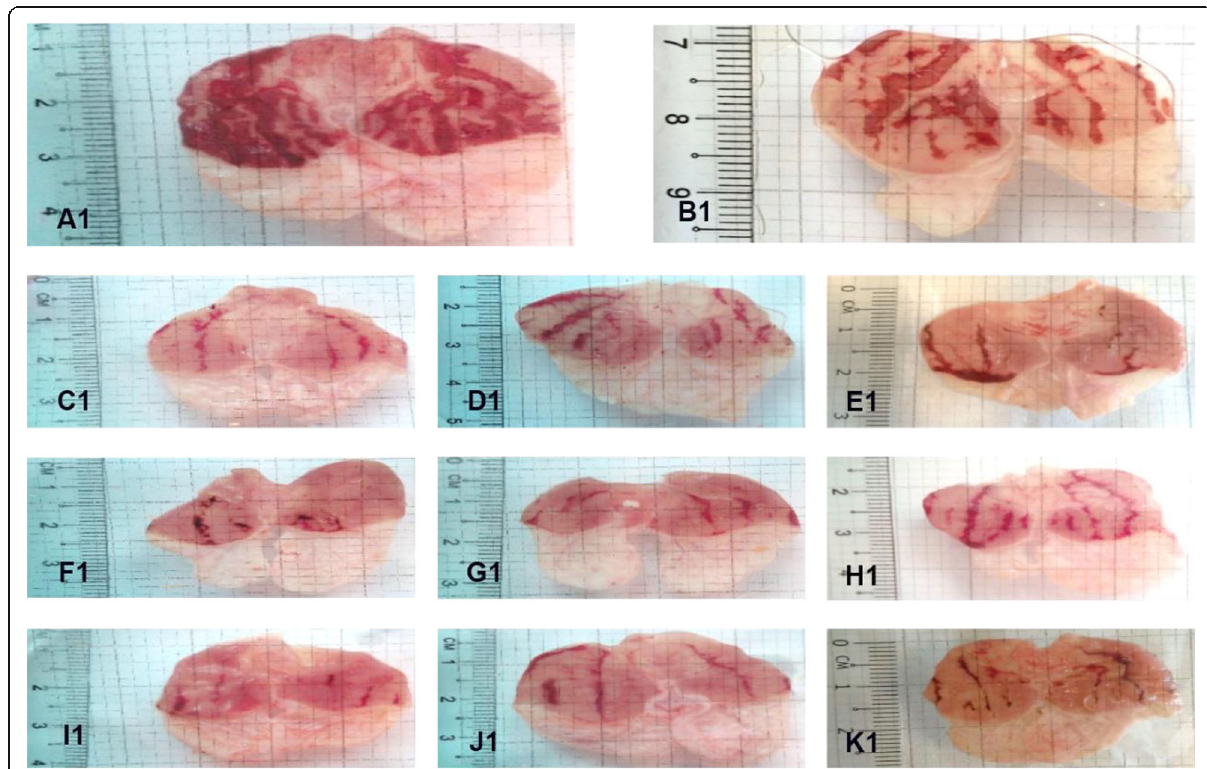
Fig. 2 Gross examination of the ethanol intoxicated gastric mucosa tissue of rats orally pretreated with various test solutions. (A1) Rats pretreated with 2% Tween 80 (ulcer control). Severe lesions observed with extensive visible hemorrhagic necrosis of gastric mucosa. (B1) Rats pretreated with ranitidine (100 mg/kg, positive control). Moderate lesions of gastric mucosa were seen compared to the lesions in ulcer control group. (C1, D1, E1) Rats pretreated with low dose of 1:1, 1:3 and 3:1 MMMC, respectively (15 mg/kg). Very moderate lesions were seen in group the D1 and E1. Meanwhile, group C1 shows mild lesions. (F1, G1, H1) Rats pretreated with 150 mg/kg of 1:1, 1:3 and 3:1 MMMC respectively. Group F1 and G1 exhibit mild lesions when compared to the group treated with 2% Tween 80. Very moderate lesion was formed in group H1. (I1, J1, K1) Rats pretreated with high dose of 1:1, 1:3 and 3:1 MMMC (300 mg/kg). Very moderate lesion was seen in group K1. Meanwhile, group I1 and J1 shows a very mild lesion, which indicates highly protection of the extract against gastric